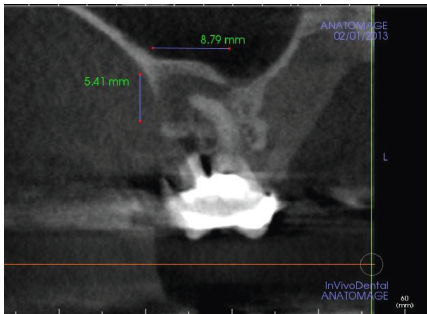
Figure 2: A cone beam CT of tooth #3 in 2013 showed periapical